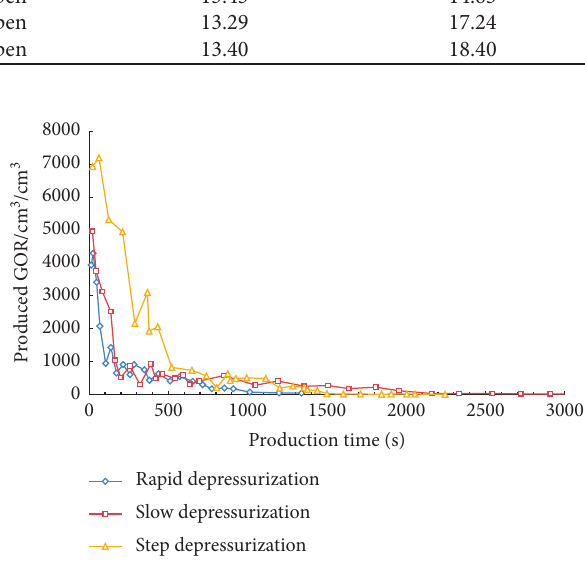
Figure 13: Pressure change of distal end during puff period of the first huff-and-puff cycle with different depressurization method.